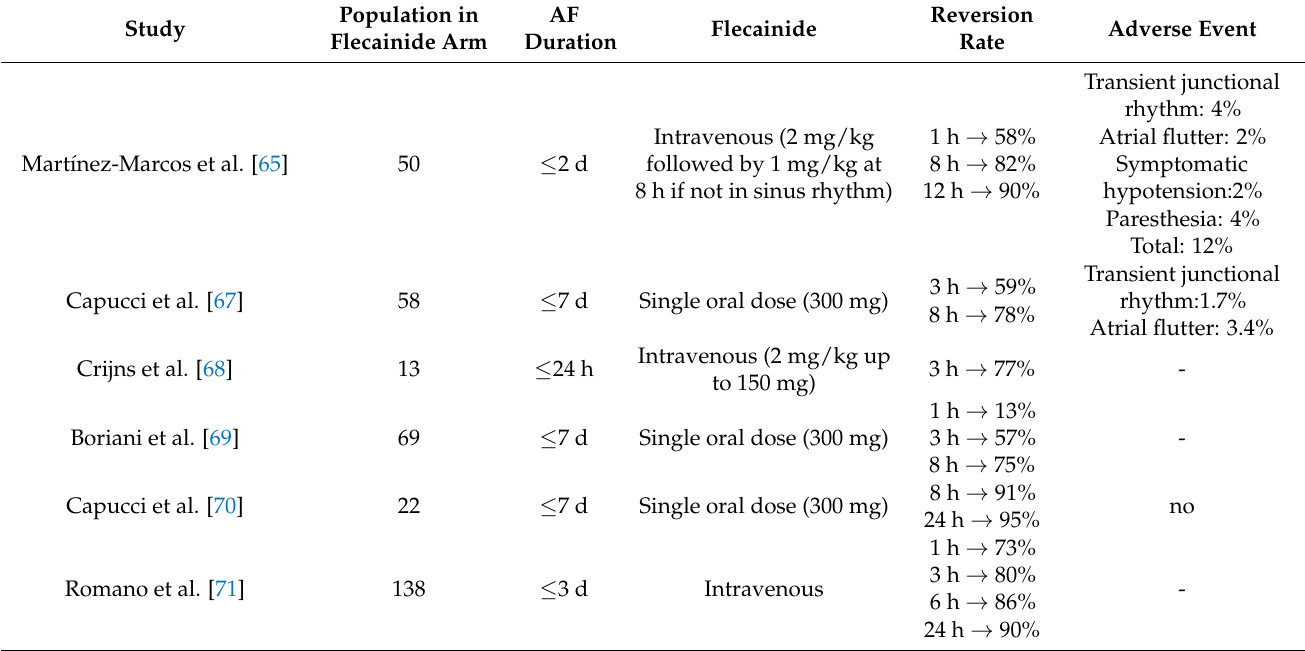
Table 3. Reversion rate of recent-onset atrial fibrillation to sinus